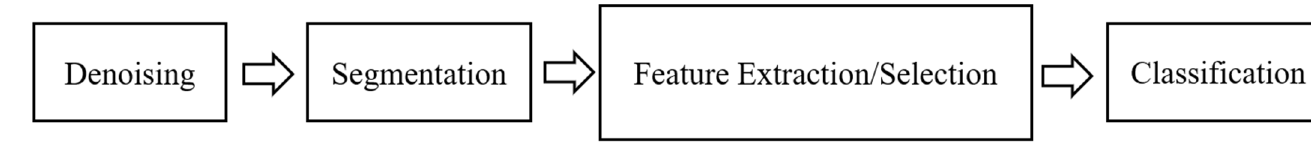
Figure 1. Four essential steps required to detect atrial fibrillation (AF).